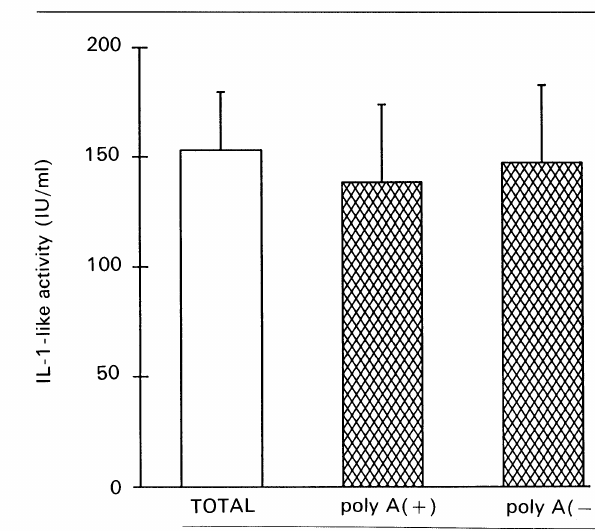
FIG. 3. The effect of the poly A(+)-RNA and poly A(-)-RNA fractions on the release of IL-1 by resident macrophages. Macrophage monolayers were incubated with total L-RNA (25#g/ml), or with the poly A(+)-RNA (0.5 #g/ml) or poly A(-)-RNA fractions (25 #g/ml) for 6 h. Results are the mean _+ S.E.M. of quadruplicates from a representative assay taken from three similar experiments. stimulated macrophage monolayers was strongly reduced by an antiserum against TNF- but not by the control serum. The effect of TNF-cz antiserum to recombinant murine TNF-0 is also shown in Fig. 2b.